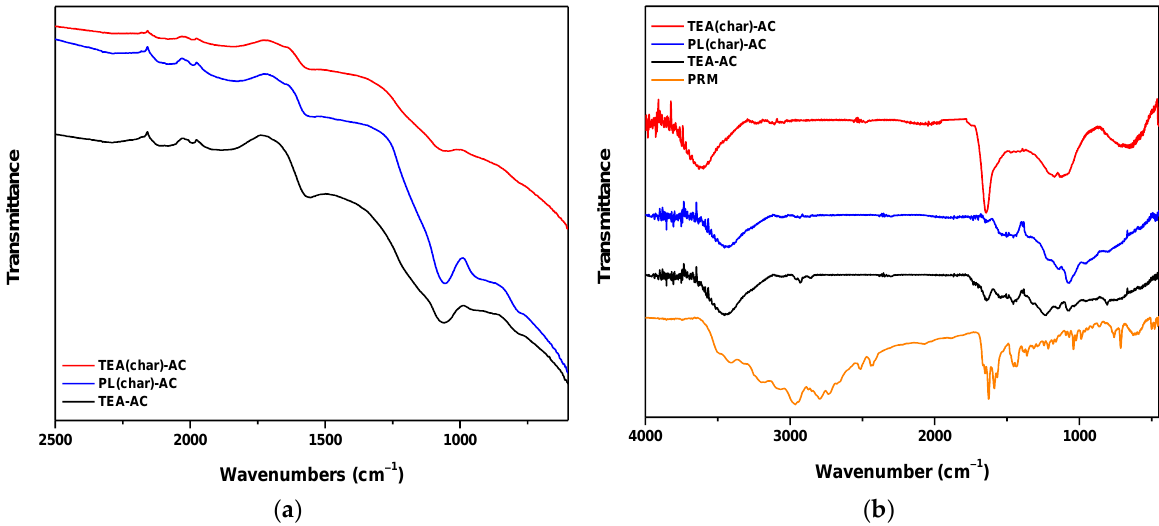
Figure 5. FTIR spectra of all studied samples ( a ) before adsorption and ( b ) after pramipexole dihydrochloride (PRM) adsorption.